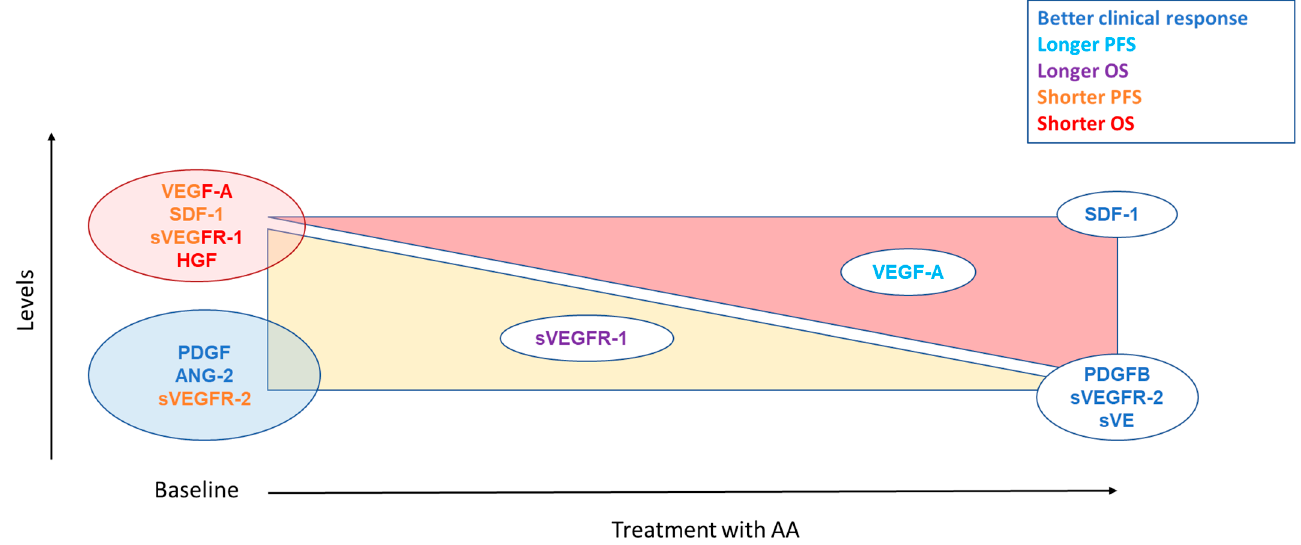
Figure 4. Summary of angiogenesis markers assessed as predictive factors for TKIs. The yellow triangle corresponds to a decrease of the markers on treatment. The red triangle indicates an increase in markers on treatment. For biomarkers placed in the middle of the triangle, it indicates that a lower decrease or a lower increase is associated with the clinical response corresponding to their color.